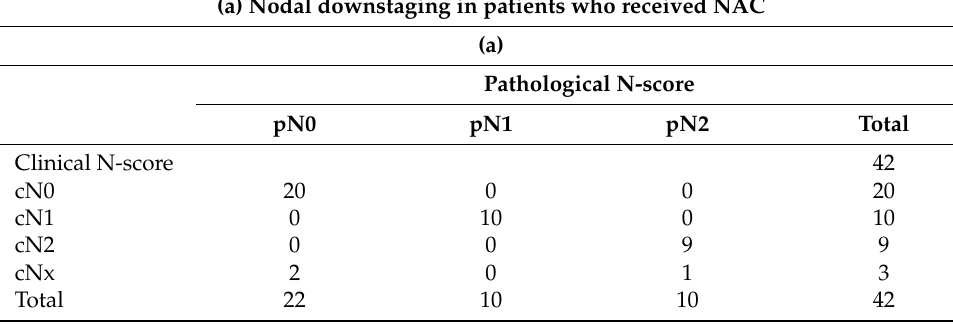
Table 5. Clinical and pathological nodal